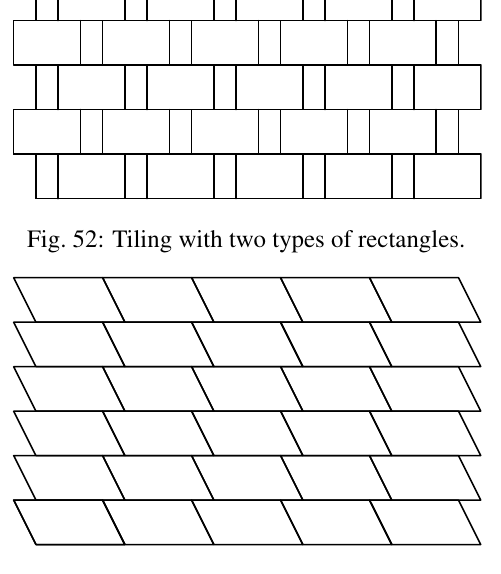
Fig. 55: Tiling with one type of rectangle (NC).